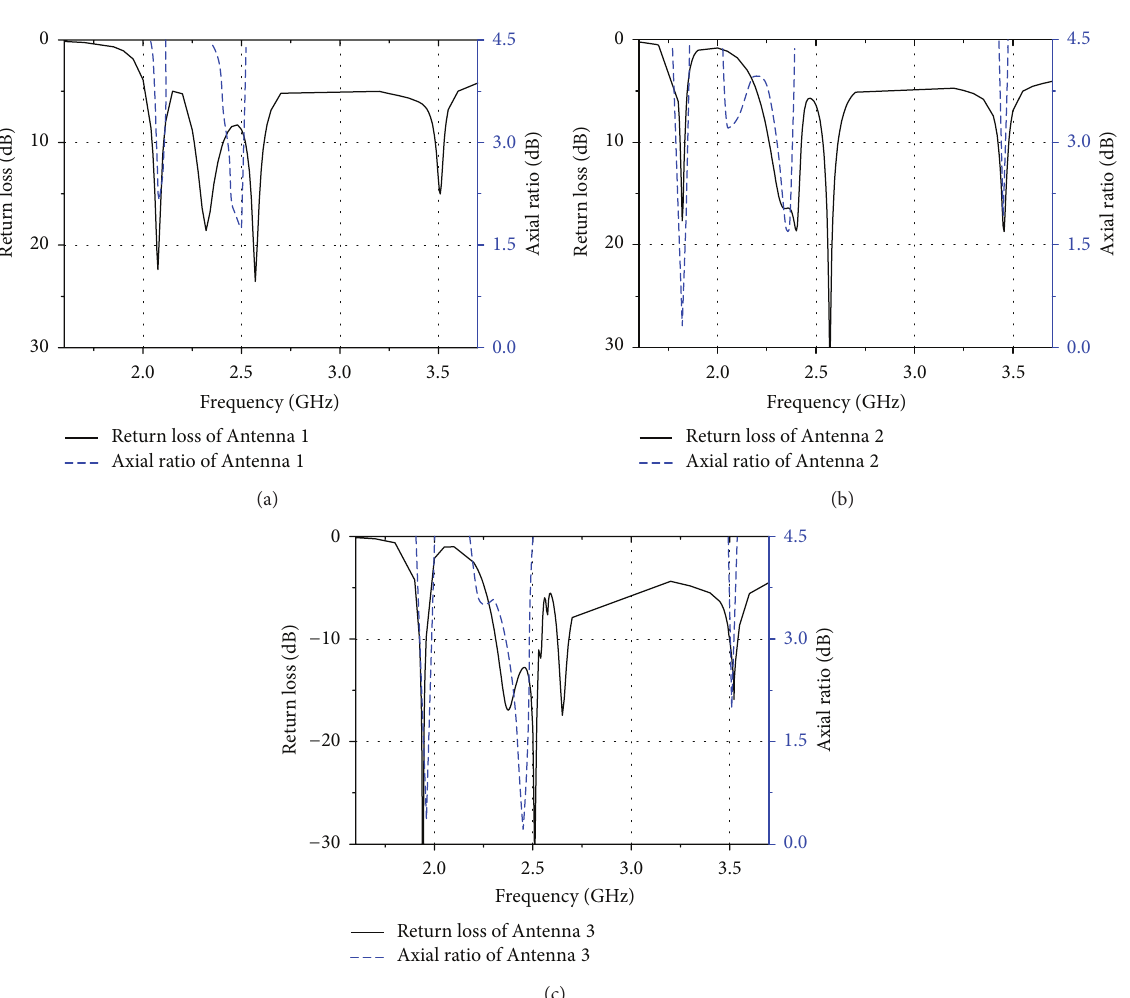
Figure 3: Simulated return loss and axial ratio (theta = 90 deg and phi = 0deg) of various antennas involved. (a) Ant. I, (b) Ant. II, and (c) Ant.